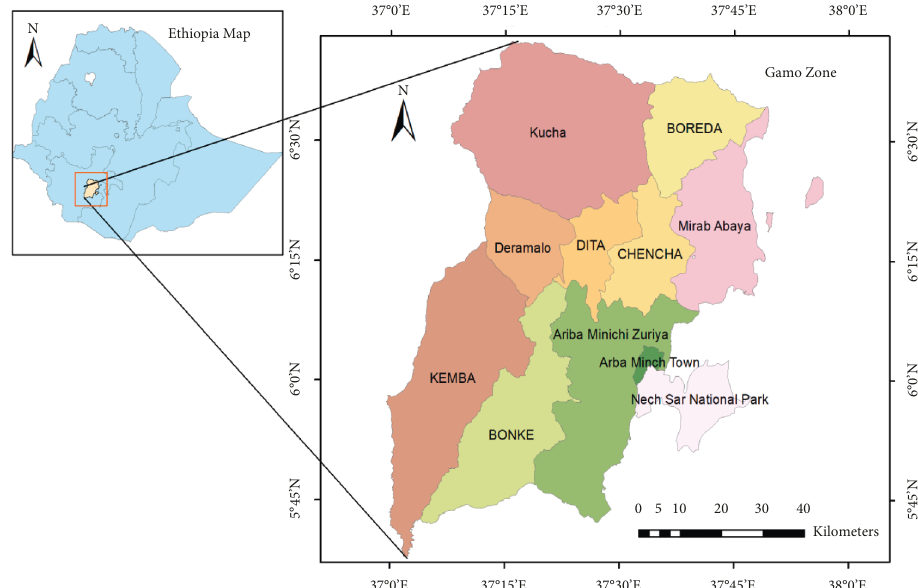
Figure 1: Map of the study